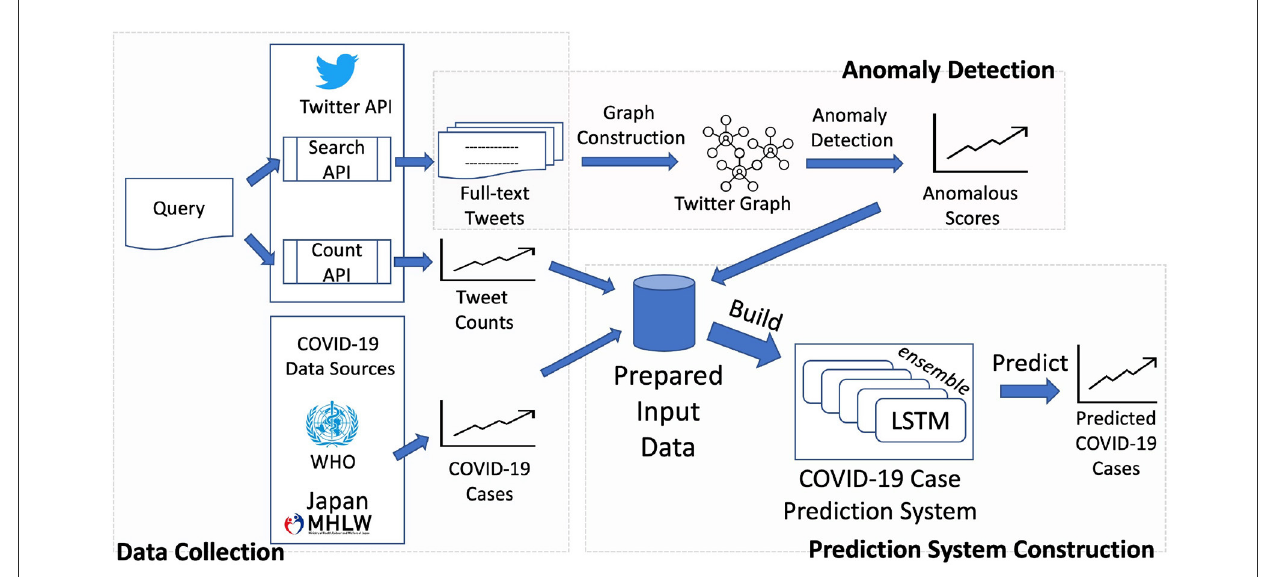
the reporting of the number of infections, posts about vaccination, and posts about Japanese government policy—the emergency state declaration and the spread-prevention policy. The details of the settings are shown in Table 1. Since location-tag is off by default and mostly not turned on by users, to select tweets in Japanese, we used the “lang” parameter provided by Twitter API with the language code “ja.” In the period from 2020/01/01 to 2022/09/30, we collected more than 20 million tweets in total. Beside the COVID-19 related tweets, we performed a count of all tweets that matched a predefined set of emoji. The total count was 8 billion for the same period. Figure 2 reveals a repetitive phenomenon: the reactions on Twitter form a wave shape corresponding to each wave of COVID- 19. Tran and Matsui (27) hypothesized such a phenomenon on the basis of behavioral changes observed from Apple mobility trends reports. This phenomenon is also potentially due to excessive negative information exposure (13, 14) and heightened risk perception of social media users.